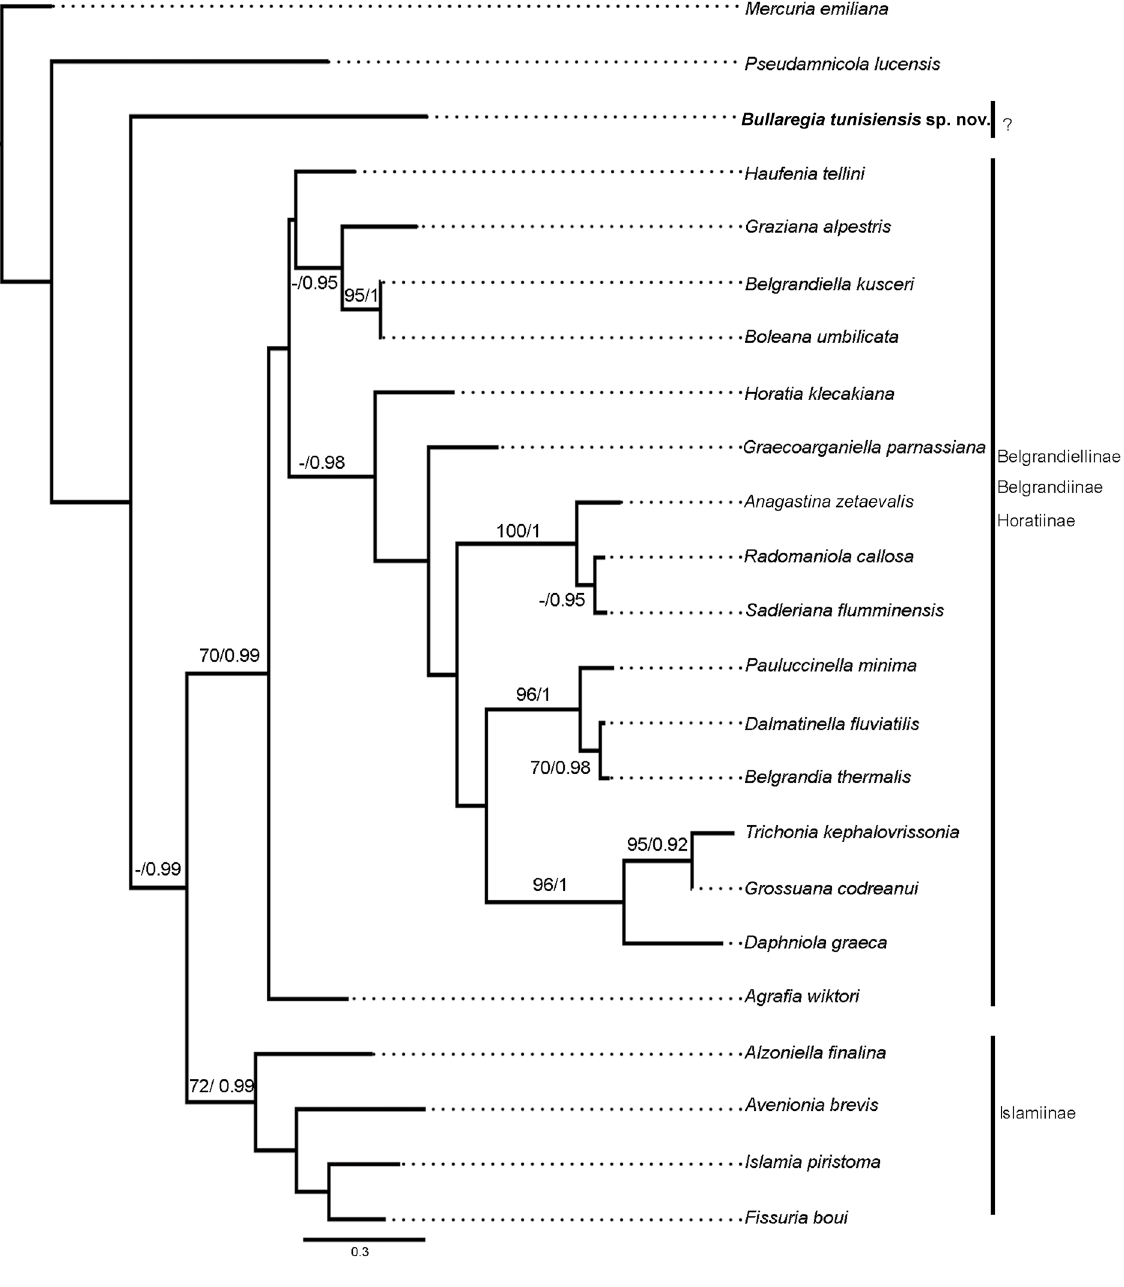
Fig. 2. Maximum likelihood inference based on COI dataset. Bootstrap values and BPP’s are given when ≥ 70% and 0.90, respectively. Black bars on the right indicate subfamily assignments. Scale bar: expected change per